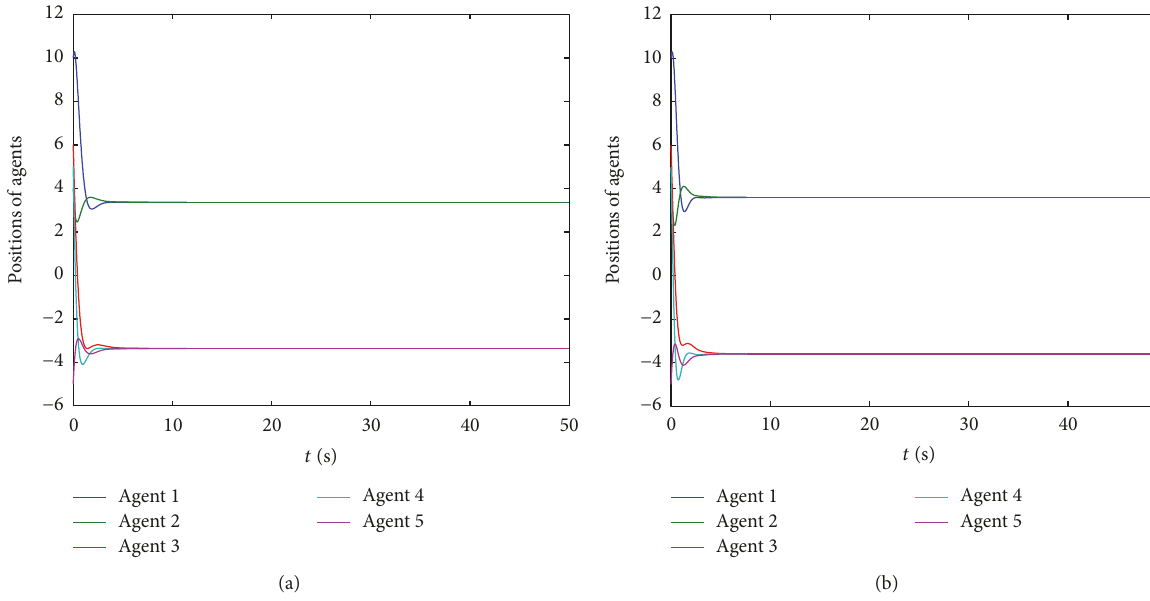
Figure 3: The state trajectories of the agents in systems (18). (a) 𝜏 = 0.1 s and (b) 𝜏 = 0.2 s.